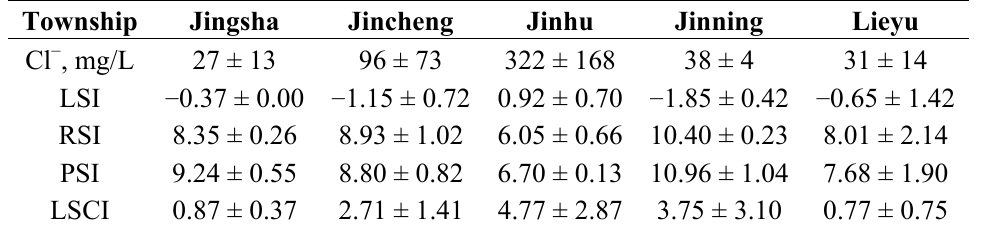
Table 5. Assessment of scaling and corrosion tendency-tap-water quality in Kinmen County [13].